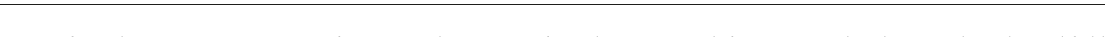
Fig. 2 ML responses to face-object pairs. a Responses of one example neuron to face-object pairs with face presented in the contralateral visual fi eld and object presented in the ipsilateral visual fi eld. Black lines represent the responses to the face-object pairs at fi ve different relative contrast levels. Red (blue) lines represent the responses to the constituent face (object) of the corresponding face-object pair when presented in isolation. b The population mean response to the same condition as in a . For each cell, responses were normalized by the mean response to all stimuli. Error bars denote the S.E. across different cells. c Population distributions of the face weight (see Methods) computed at fi ve relative contrast levels. The red dashed lines denote the median values of the distribution, which are 0.84, 0.88, 0.96, 0.93, 0.95 (from top to bottom). The black triangles denote the mean values of the distributions. d – f Same as a – c , for the condition in which faces were presented in the ipsilateral visual fi eld and objects in the contralateral visual fi eld. The median values in b3 are 0.21, 0.34, 0.46, 0.61, 0.78. p values displayed in f indicate the t -test signi fi cance value comparing the population distributions of the face weights between the two horizontal conditions for each contrast level. g – i Same as for a – c , for the condition in which faces were presented above the fi xation point and objects were presented below the fi xation point. The median values in c3 are 0.96, 0.85, 0.89, 1.08, 0.89. j – l Same as for a – c , for the condition in which faces were presented below the fi xation point and objects above the fi xation point. The median values in d3 are 0.68, 0.85, 0.90, 0.98, 0.99. p values displayed in l indicate the t -test signi fi cance values for comparing the population distributions of the face weights between the two vertical conditions for each contrast level. The face image used in this fi gure was taken from the FERET face database 51,52 . The bowling bag image used in this fi gure is similar to the one actually shown, but due to copyright reasons, we cannot show the